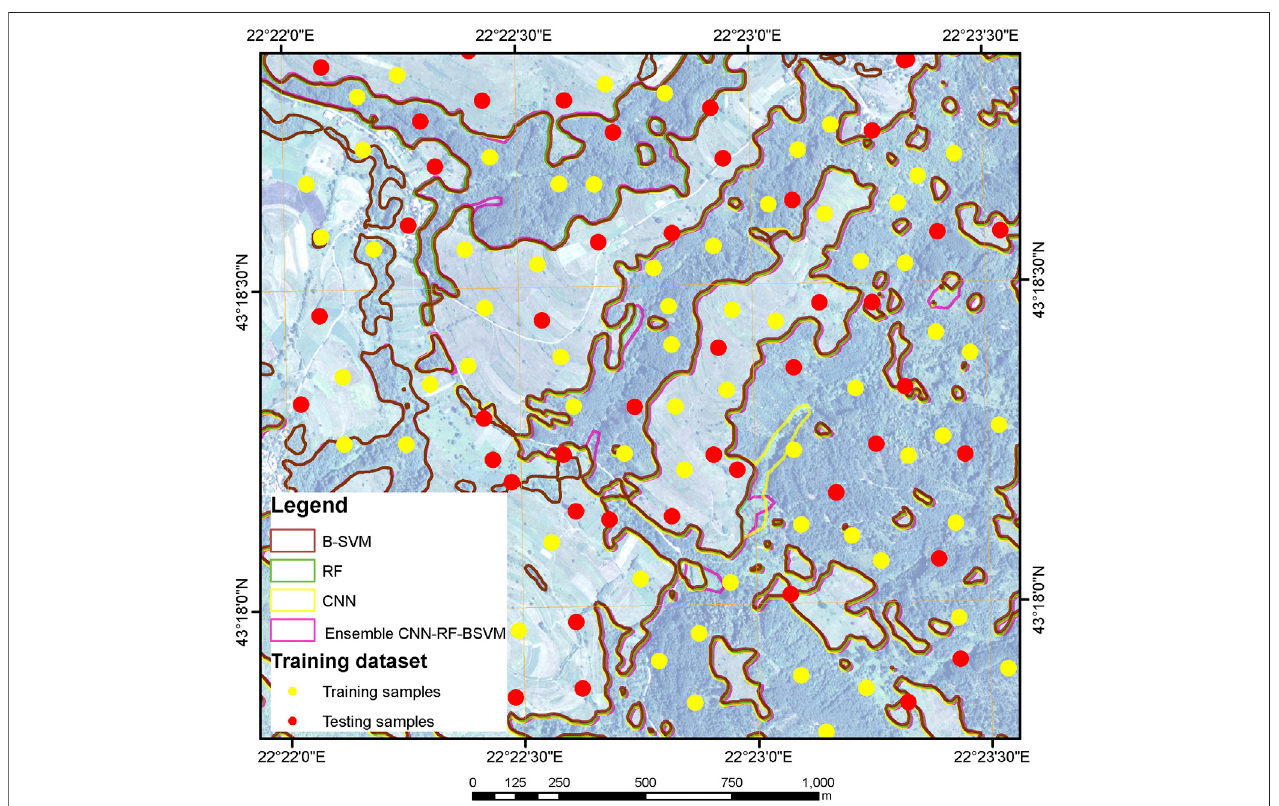
FIGURE 4 | Results of vegetation classi fi